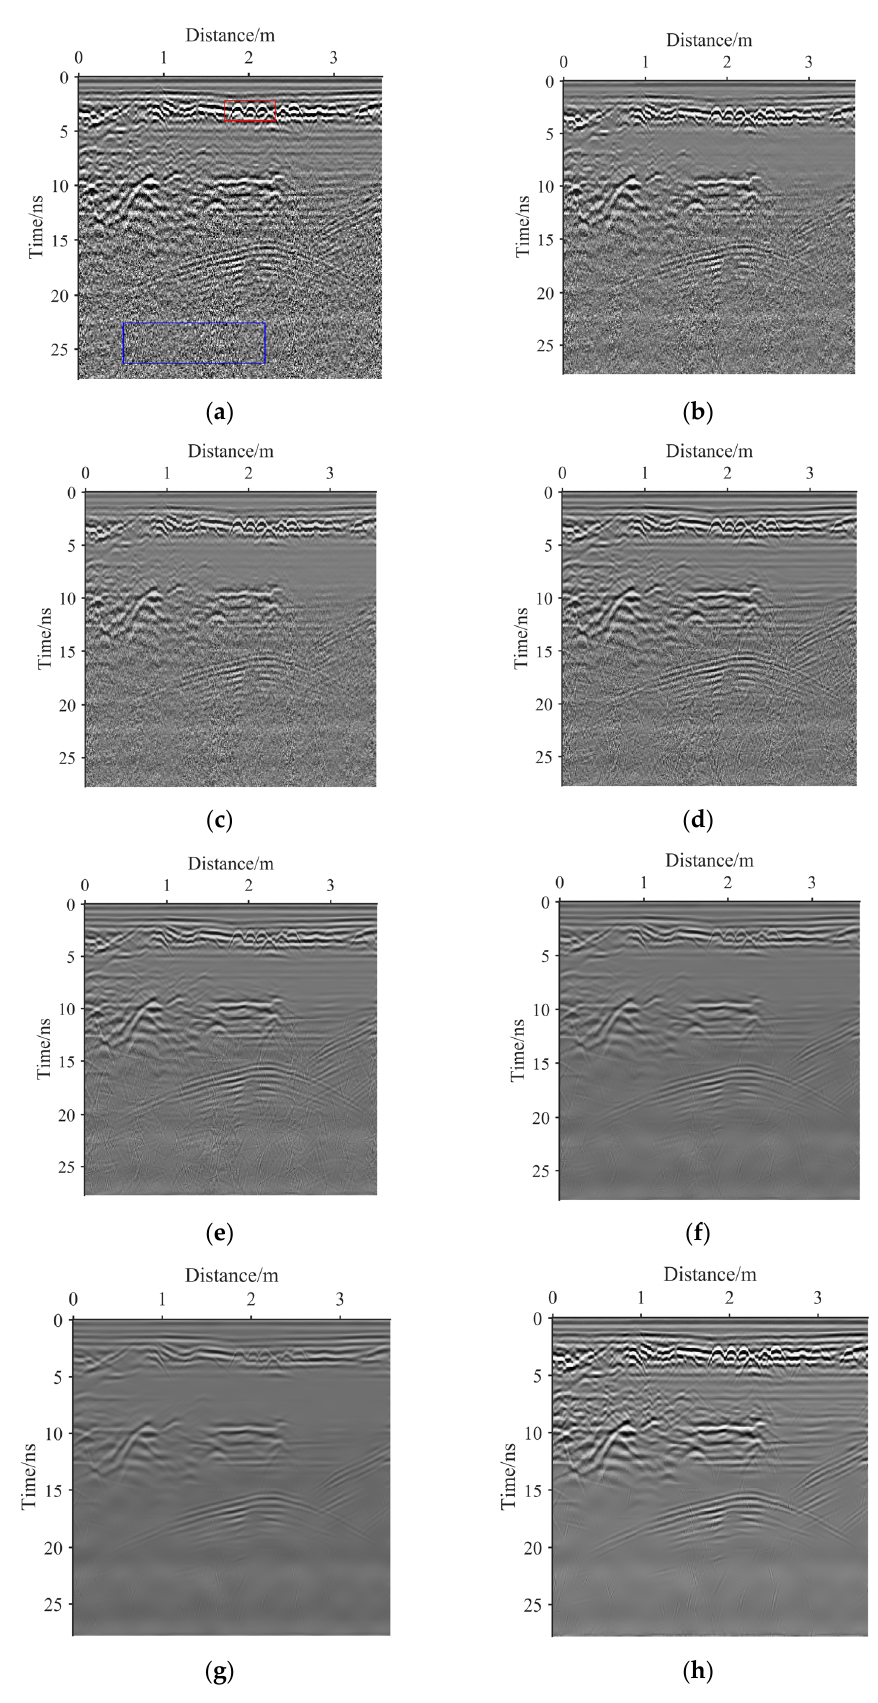
Figure 12. ( a ) The original real GPR image 2. ( b ) The result of bilateral filter. ( c ) The result of